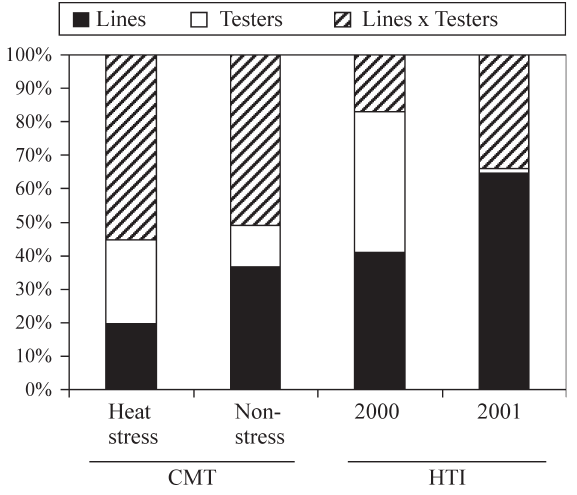
Figure 1 - Relative contribution of lines (females), testers (males) and lines x testers to total genotypic variation in cellular membrane thermo- stability (CMT) and heat tolerance index